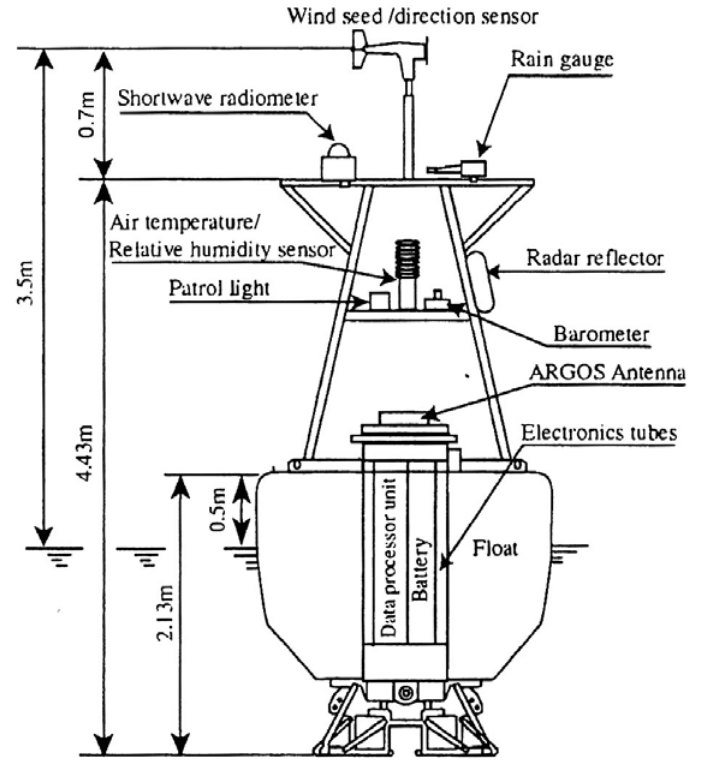
Figure 1. Schematic of the TRITON buoy.